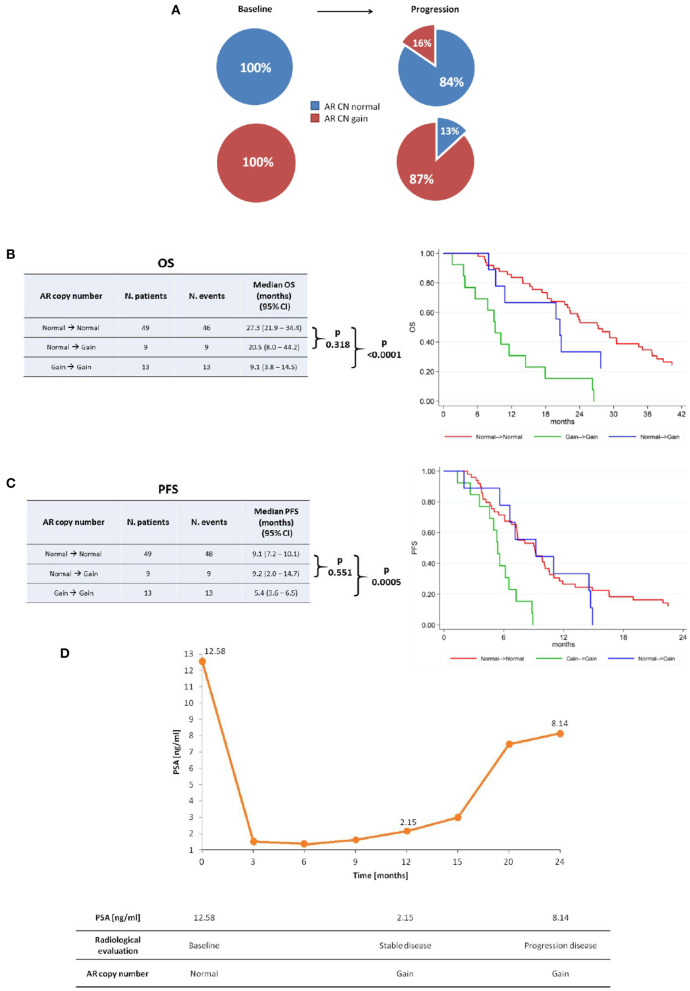
AR copy number changes. (A)
AR copy number changes from baseline to progression time point. Median OS (B) and PFS (C) of stable AR CN normal, AR CN changing from normal to gain, and stable AR CN gain patients with the corresponding Kaplan–Meier curves. (D) Representative case that changed AR CN from normal to gain at stable disease and remained gain at disease progression, even though PSA response occurred.